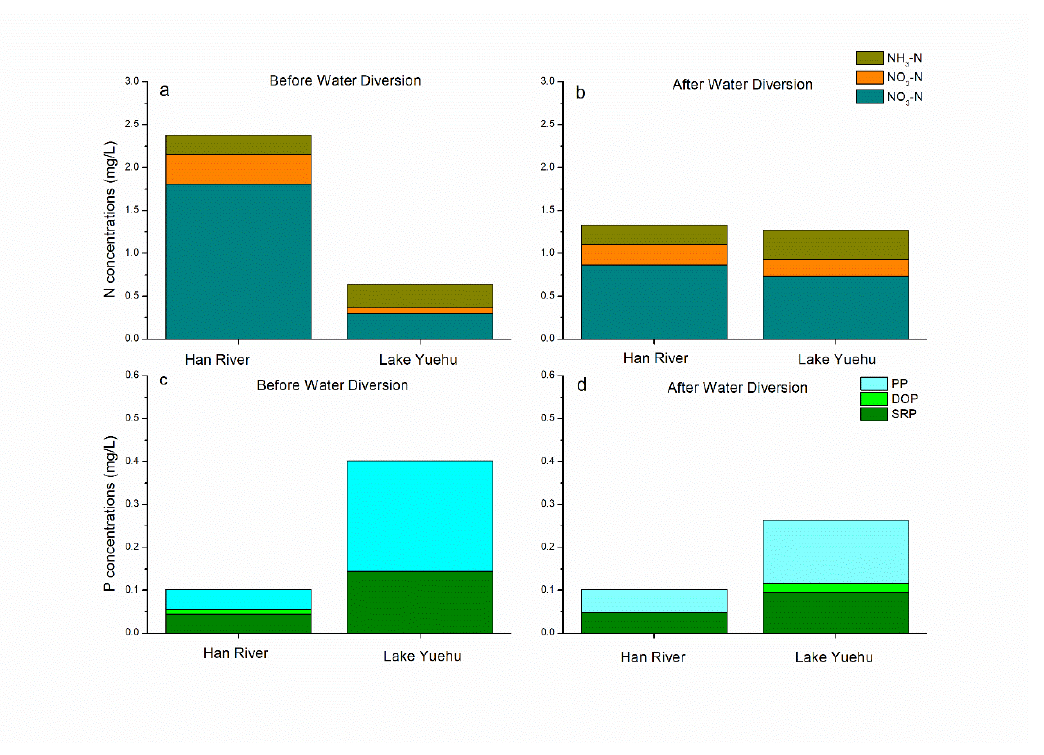
Figure 2. Concentrations of different forms of N and P of before and after water diversion in the Han River and Lake Yuehu. ( a ) Different forms of N before water diversion; ( b ) different forms of N after water diversion; ( c ) different forms of P before water diversion; ( d ) different forms of P after water